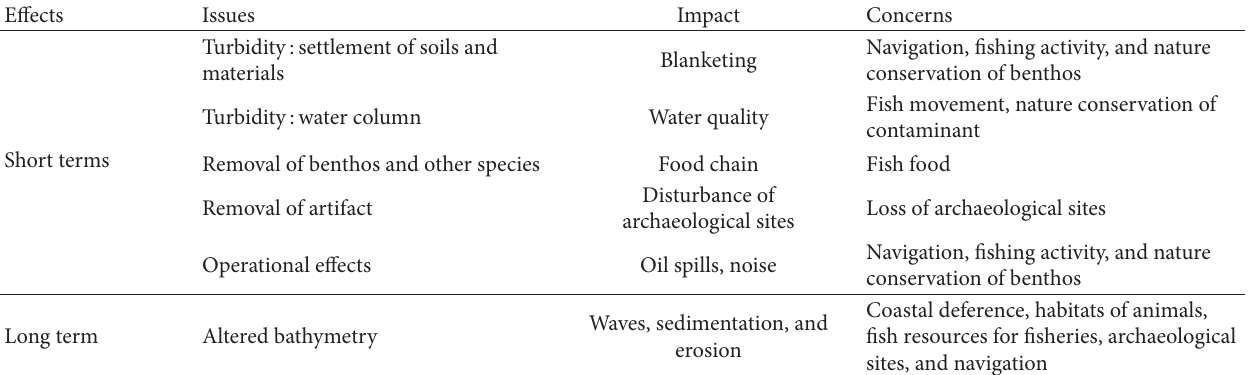
Table 1: Dredging and dumping effects